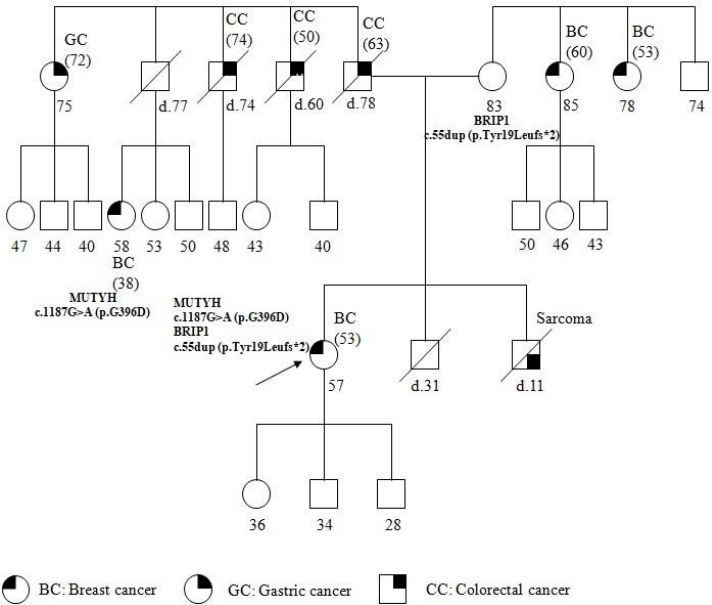
Figure 1. Pedigree of family carrying the MUTYH mutation c.1187G>A (p.G396D) and BRIP1 mutation c.55dup (p.Tyr19Leufs*2). The age at diagnosis is indicated in brackets.